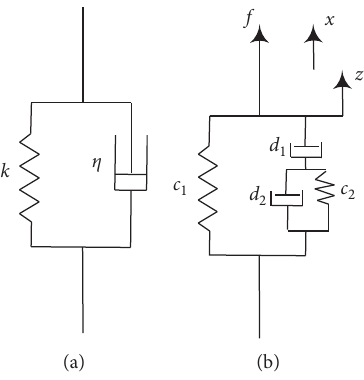
Figure 6: Model of the main rubber spring [85]: (a) Kelvin–Voigt model; (b)